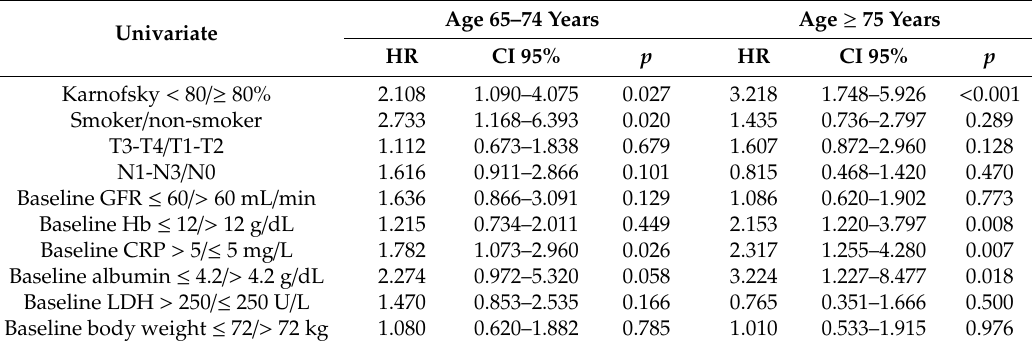
Table 3. Univariate analysis of baseline parameters regarding OS in dependence of the age group of elderly HNSCC patients ( n =